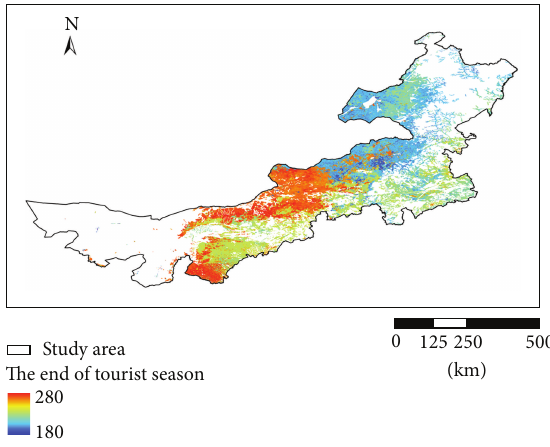
Figure 6: The end of grassland tourist season.